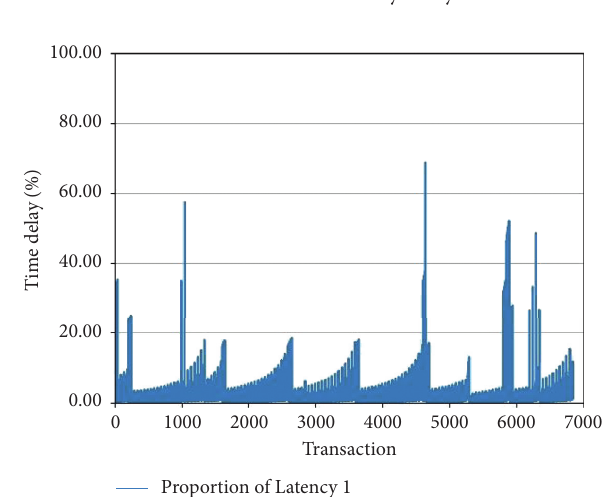
Figure 8: Transaction delay analysis.